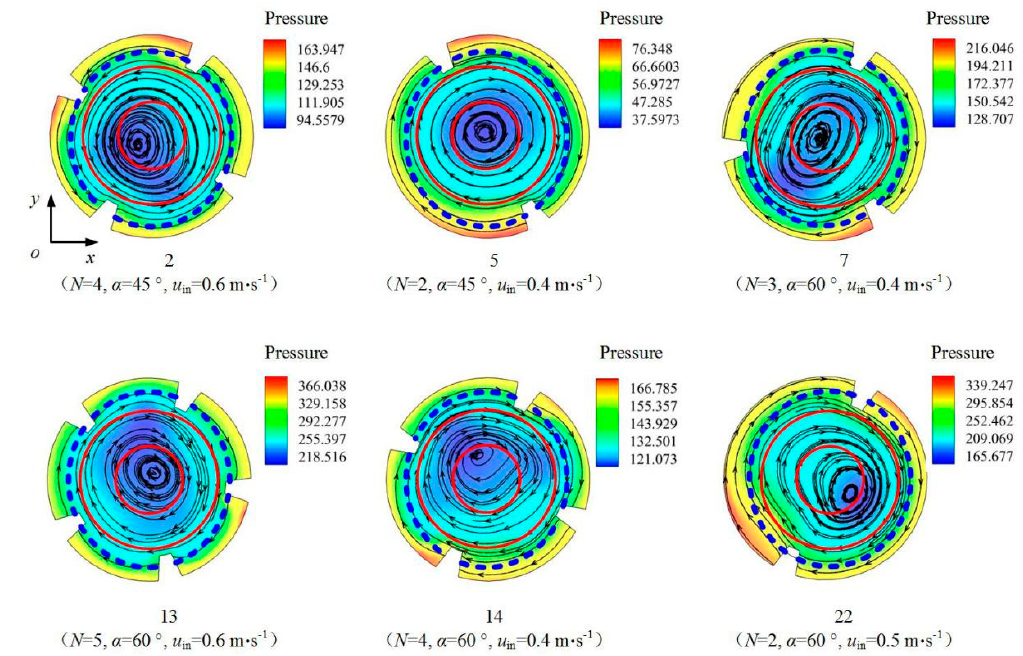
Figure 11. Pressure distributions and L/D boundaries (double-sided illumination) on the z = 2.5 m cross section of the PBR in tests 2, 5, 7, 13, 14, and 22.